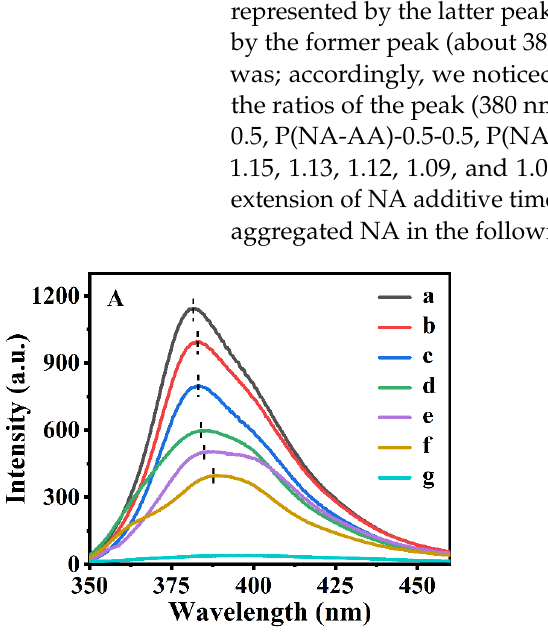
Figure 1. Emission spectra of P(NA-AA)-x-0.5 doped with NA at different times ( A ) and P(NA- AA)−0−y (B) with various doped amount of NA ( B ). ( A ): (a) P(NA-AA)-0-0.5P(NA- AA)−0−0.5 , (b) P(NA- AA)−0.2−0.5 , (c) P(NA- AA)−0.5−0.5 , (d) P(NA- AA)−1−0.5 , (e) P(NA- AA)−3−0.5 , (f)